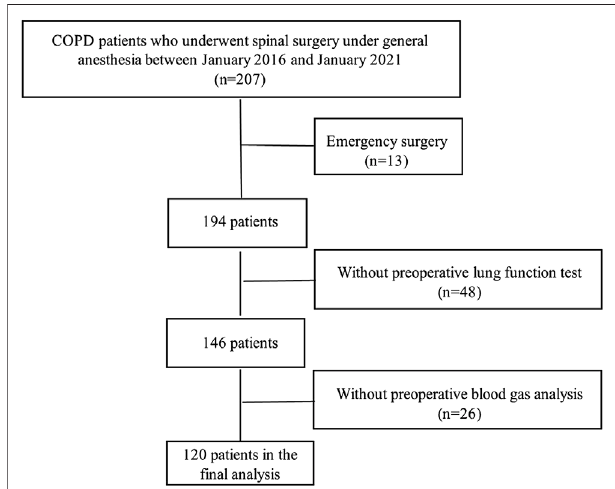
FIGURE 1 | Flow diagram for patients.